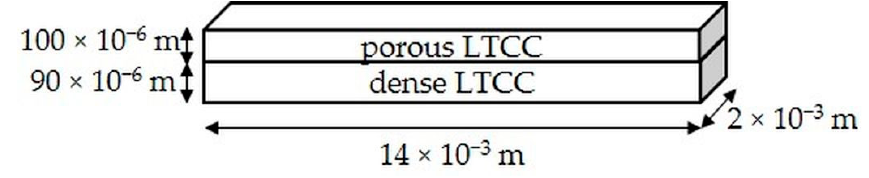
Figure 2. Geometry of the LTCC bilayer.